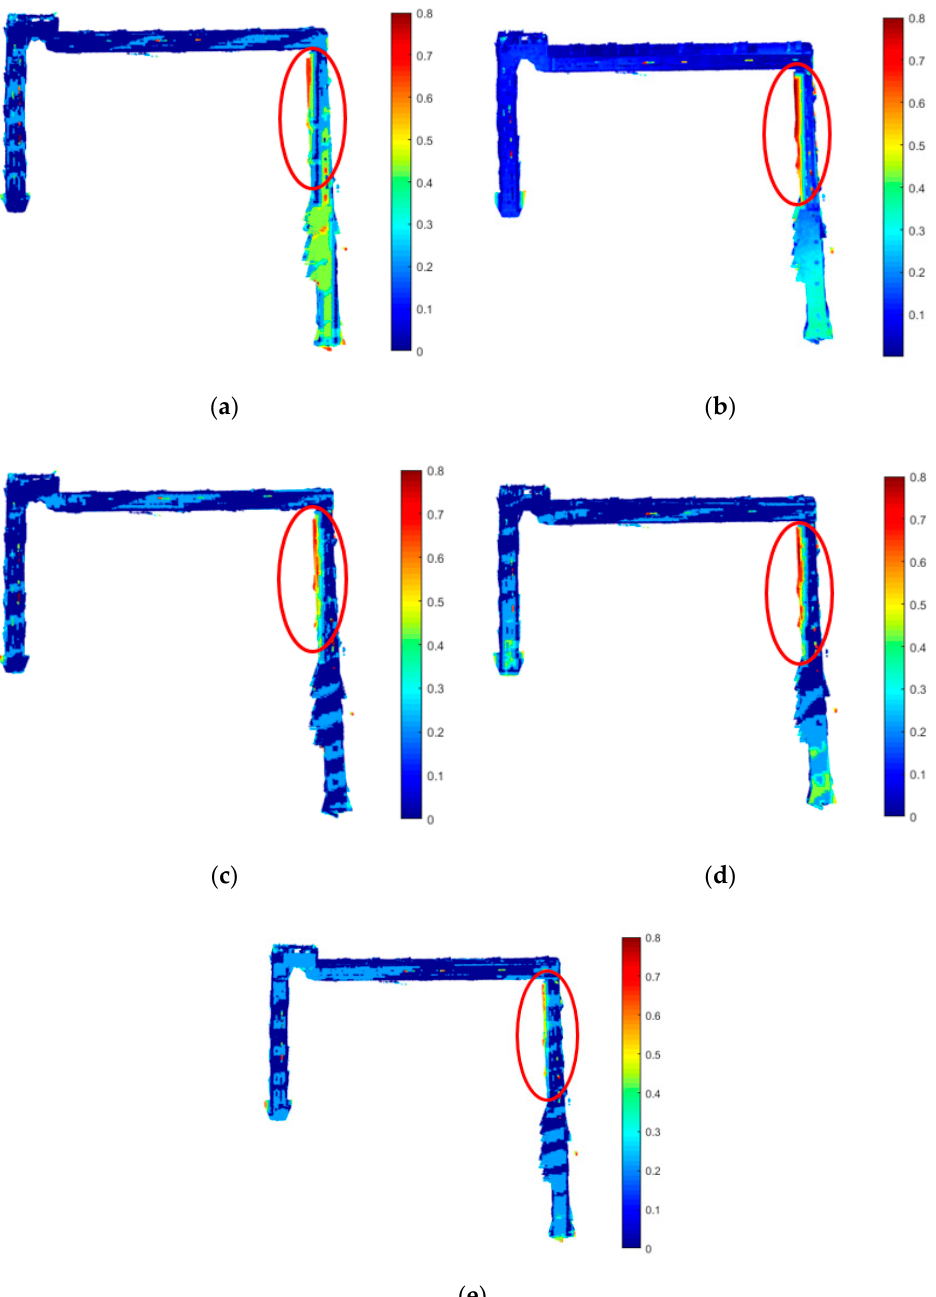
Figure 11. Point-to-point distances between reconstruction models and ground truth. ( a ) ORB-SLAM; ( b ) Point; ( c ) Point + 3D Line; ( d ) Point + 2D Line; ( e )